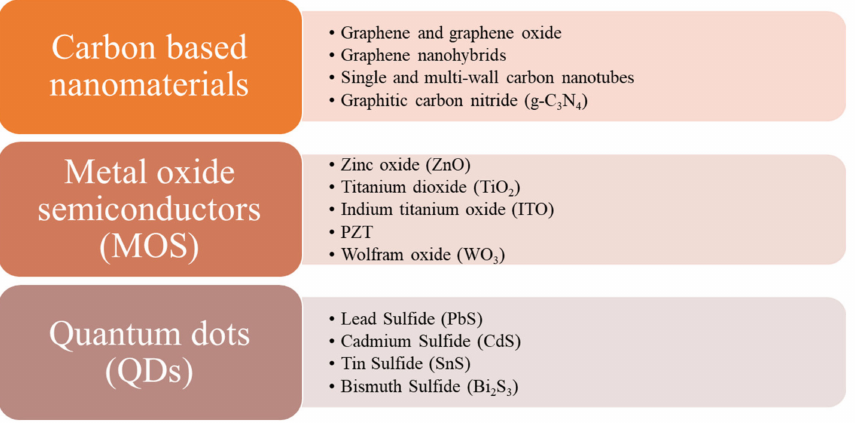
Figure 1. State-of-the-art nanomaterials for NO 2